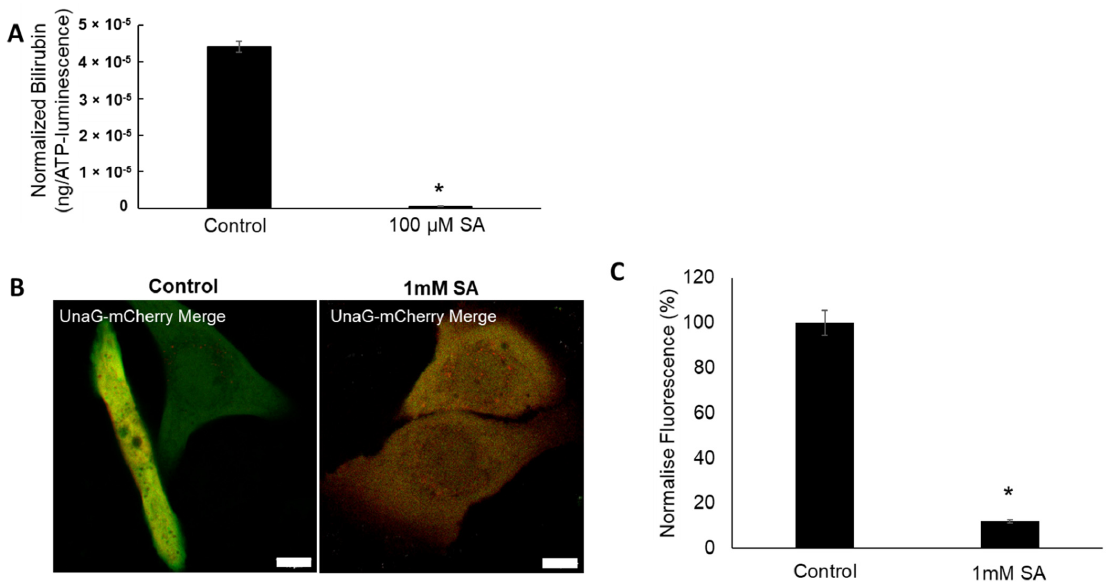
Figure 3. ( A ) De novo bilirubin synthesis in keratinocytes with or without succinyl acetone (SA, an inhibitor of ALA dehydratase) for 48 h. Bar indicates mean ± SEM. n = 4/group. *; p < 0.05 vs. un- treated control group. ( B ) Representative images of untreated control keratinocytes (left, endogenous bilirubin) and keratinocytes treated with SA for 48 h (right). Scale = 10 µm. ( C ) Quantification of UnaG green fluorescence (bilirubin) by image analysis in nontreated control and 1 mM SA-treated keratinocytes for 48 h. SA treatment inhibited intracellular production of bilirubin. Bar indicates mean ± SEM. *; p = 0.001 versus control.